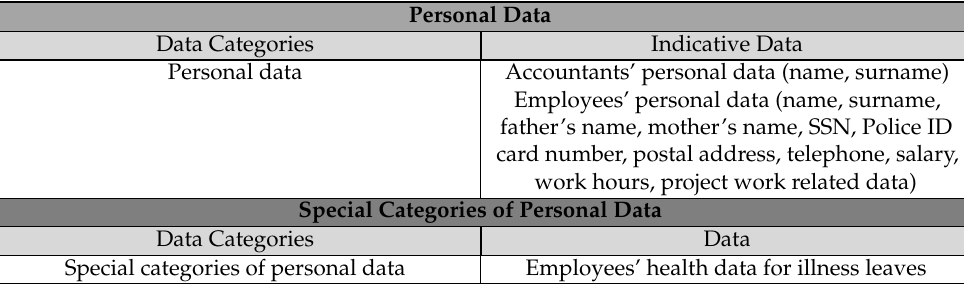
Table 3. Data processed under financial